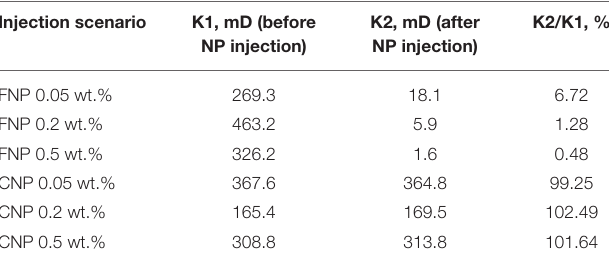
TABLE 2 | Permeability of core plugs before and after nanofluids injection. Injection